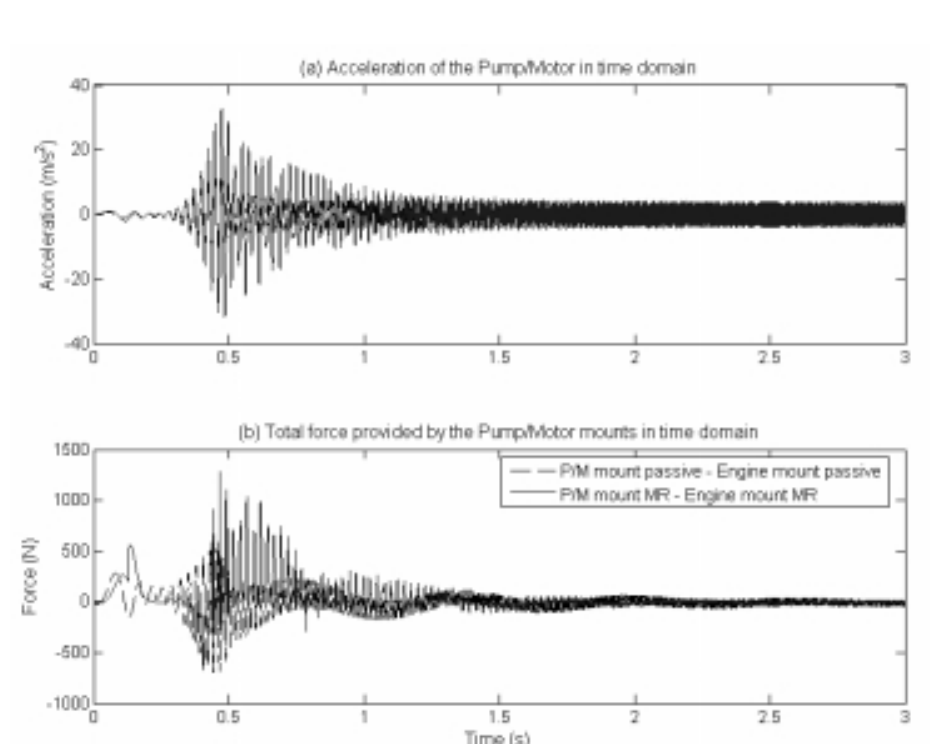
Fig. 8. Acceleration of the P/M in time domain (a) and force provided by the P/M mounts in time domain (b). indicates that the MR mount with skyhook controller is capable of providing high enough damping force that can reduce the body’s vibration